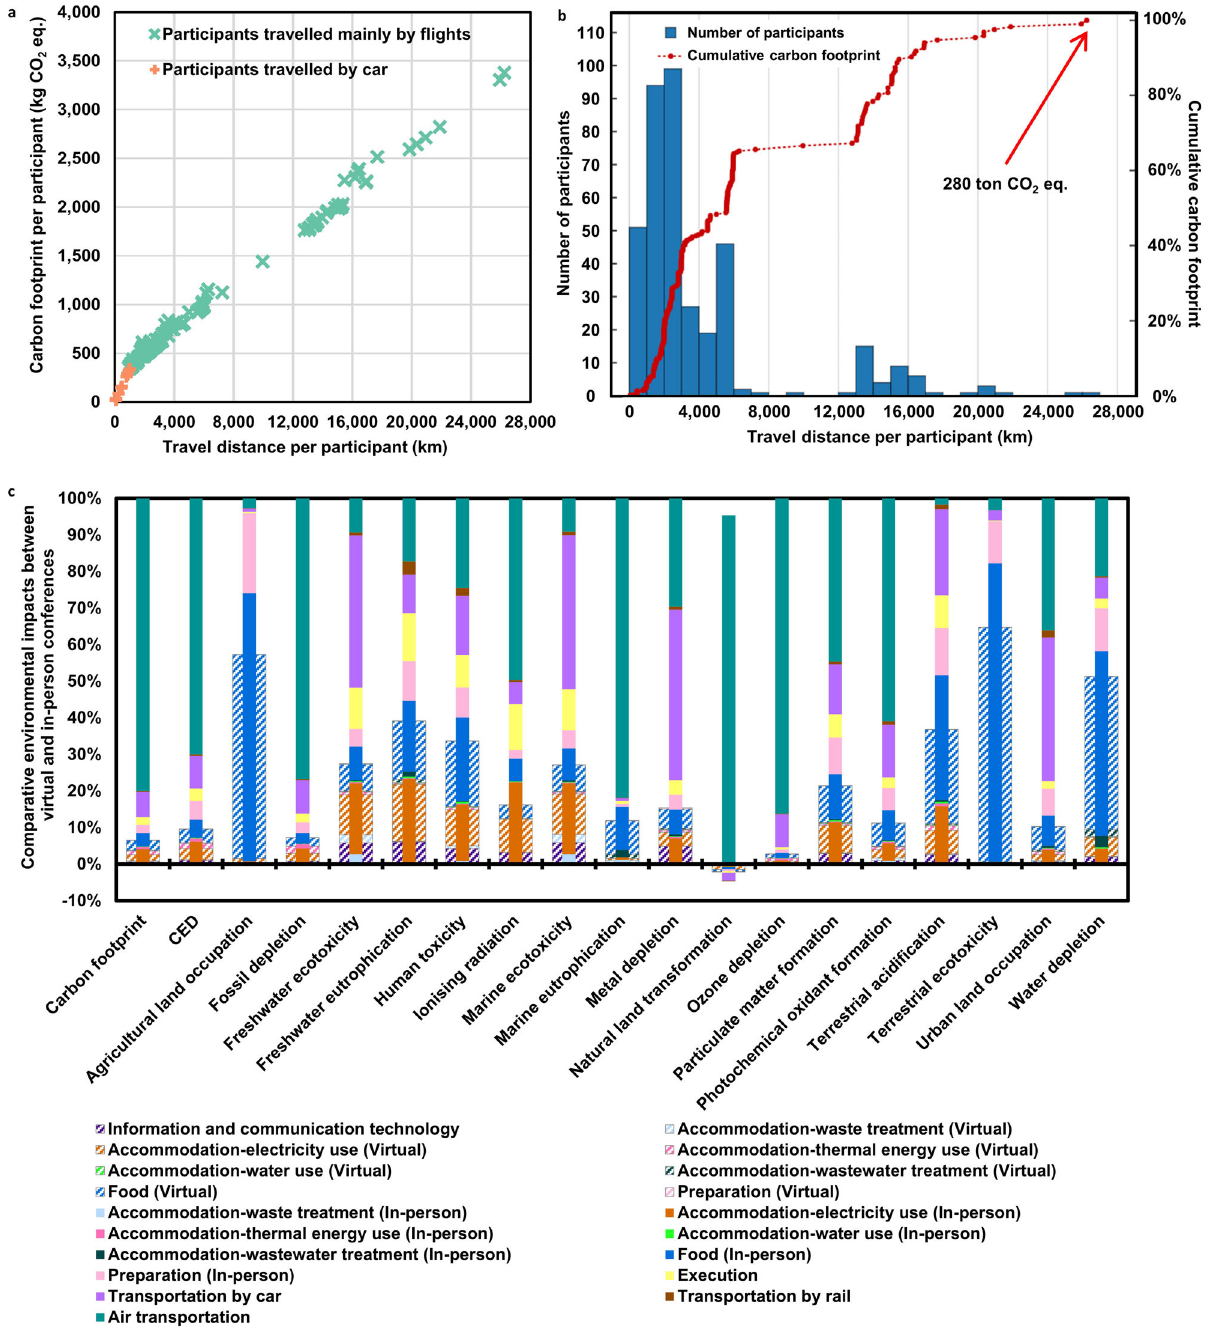
Fig. 2 Comparison between the 1-hub in-person conference and the virtual conference. a Carbon footprint associated with transportation for individual participants, indicating that the per pkm carbon footprint for trips primarily by plane (slope of cyan dashed line) tends to be smaller than that for driving (slope of orange dashed line). b Cumulative carbon footprint for participants with increasing travel distances, showing that 50% of the greenhouse gas (GHG) emissions for all participants ’ trips result from long-distance travels with a round-trip distance of over 10,000 km. c Environmental pro fi les of the virtual conference and in-person conference with only one hub, suggesting the environmental and energy sustainability of virtual conference in all impact categories. Colors represent different processes within the life cycle stages. Speci fi cally, transitioning from in-person to virtual conferencing reduces the carbon footprint by 94% and cumulative energy demand (CED) by 90%. Among the impact categories at the midpoint level, air transportation dominates fossil depletion, marine eutrophication, natural land transformation, ozone depletion, and photochemical oxidant formation for the 1-hub in-person scenario. And food preparation, electricity consumption at home, and information communication technology (ICT) services contribute to the majority of each impact category for the baseline virtual scenario. Moreover, agricultural land occupation, terrestrial ecotoxicity, and water depletion are dominated by food preparation for both in-person and virtual conferences. CO 2 eq., CO 2